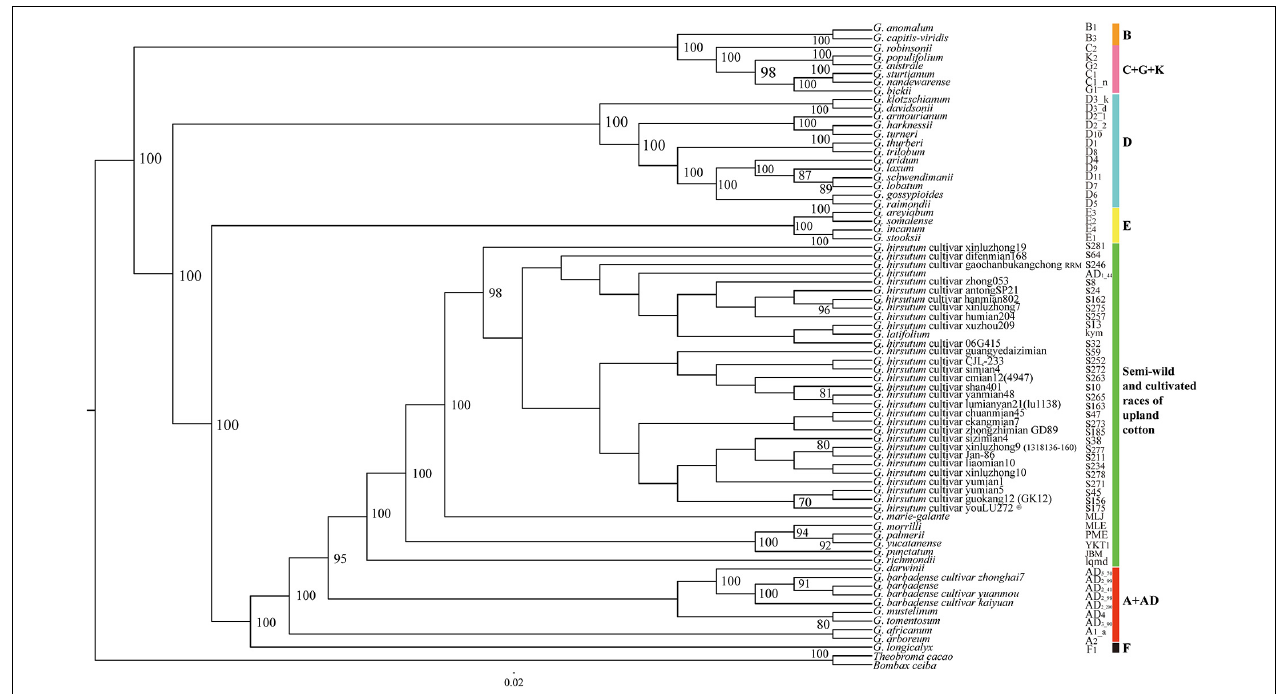
FIGURE 1 | Phylogenetic relationships among 72 Gossypium accessions based on complete chloroplast genomes. Green represents the cultivated accessions and semi-wild races of upland cotton, and other colors represent six genetic clades. B. ceiba and T. cacao were used as outgroups.